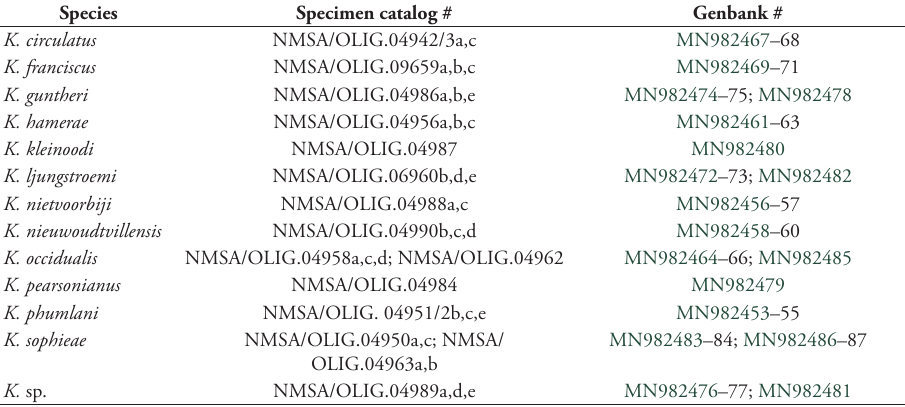
Table 1. Genbank COI sequences for investigated Kazimierzus species.